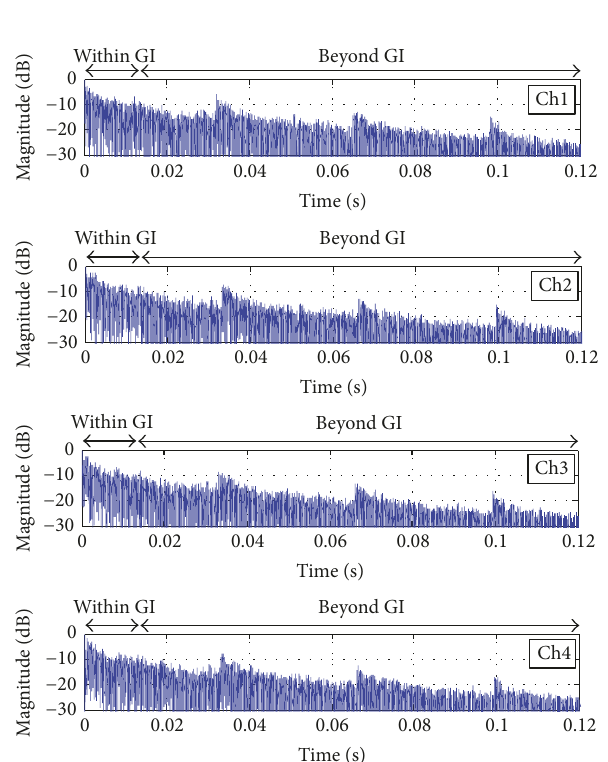
Figure 15: Delay profile for 20 m distance.